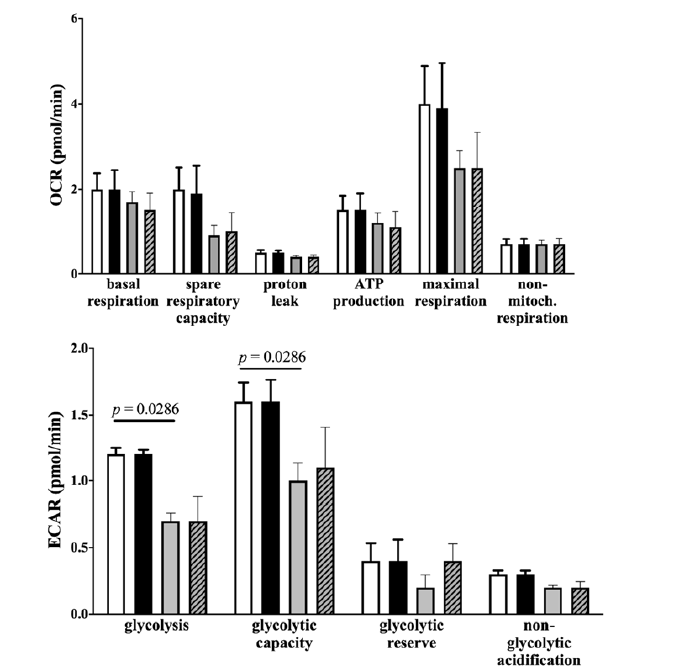
Figure 3. Energy metabolism is modified by TDP-43 overexpression but not conditioned medium. Top: Oxidative phosphorylation represented by oxygen consumption rate (OCR). Bottom: Glycolysis represented by extracellular acidification rate (ECAR). Naïve HEK-293T incubated in TDP-43-conditioned medium did not display significant changes compared to cells incubated in NT ‐ conditioned medium. However, HEK ‐ 293T overexpressing TDP ‐ 43 in NT ‐ conditioned medium revealed significantly lowered glycolysis and glycolytic capacity. Values represented in pmol/min were normalized to ng of DNA content per mL of sample. Data are presented as mean ± SEM. N = 4. Statistical test: Mann–Whitney non ‐ parametric t ‐ test.